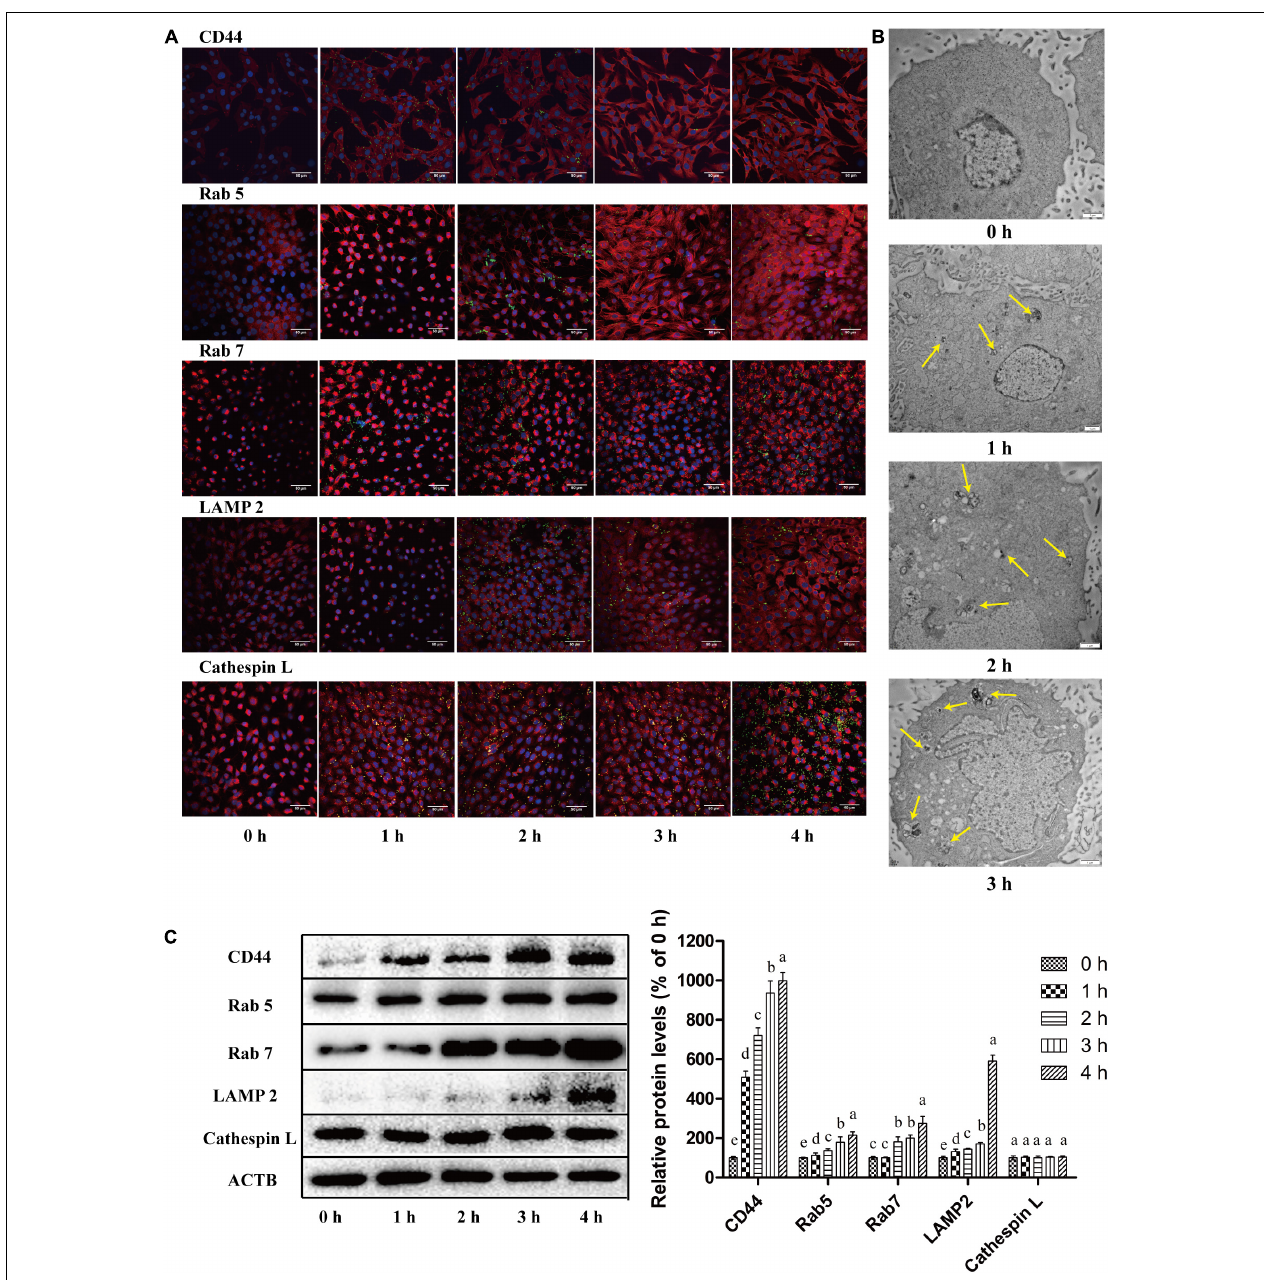
FIGURE 2 | Bacterial endocytosis and intracellular transport of C. sakazakii in HBMEC after the invasion. (A) The expression and localization of endocytosis-related proteins (CD44, Rab5, Rab7, LAMP2, and Cathepsin L) (red fluorescence) in HBMEC (DPAI, blue fluorescence for cell nucleus) infected with C. sakazakii (labeled with GFP, green fluorescence) were analyzed with immunofluorescent staining and observed with a confocal laser scanning microscope. (B) The C. sakazakii -containing endocytosis vacuoles (yellow arrows) were examined in HBMEC using transmission electron microscopy after infection. (C) The expression levels of CD44, Rab5, Rab7, LAMP2, and Cathepsin L in C. sakazakii -infected HBMEC were detected with Western Blot using ACTB as a control. Representative blots for proteins (left) and quantitative analysis (right) were presented. Bars represent the means ± standard deviations ( n = 3). Mean values with different lower-case letters are statistically different ( P <